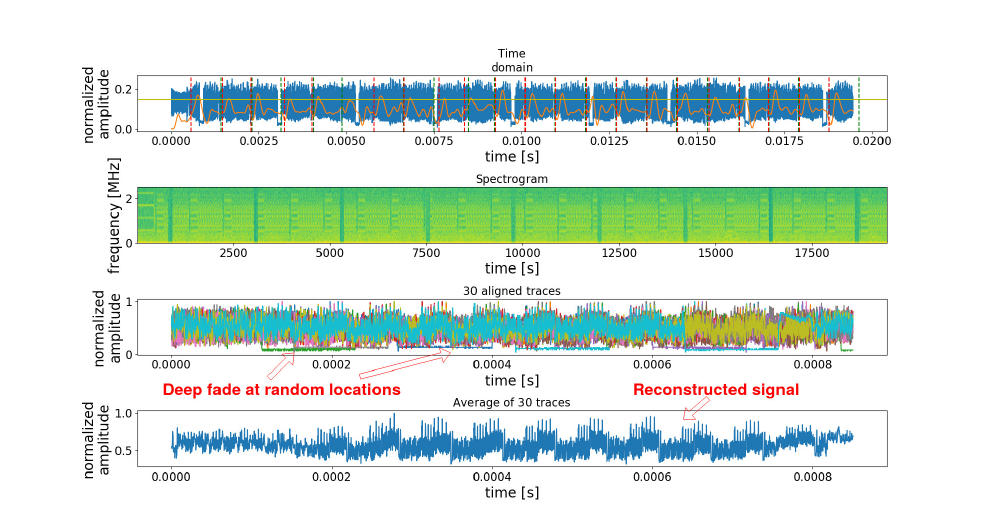
Figure 2: Screaming Channels preprocessing as a form of time diversity: averaging reconstructs the tinyAES trace despite the holes between